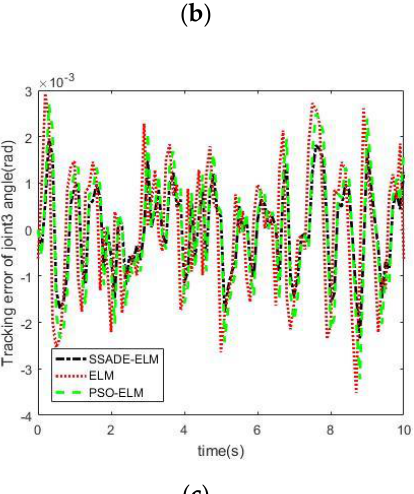
Figure 11. The tracking error of each joint trajectory of control algorithms by experiment. ( a ) The tracking error of Joint1 trajectory of control algorithms; ( b ) The tracking error of Joint2 trajectory of control algorithms; ( c ) The tracking error of Joint3 trajectory of control algorithms. Table 4. The average error of joint tracking of control algorithms by experiment. (SSADE–ELM = Strategy Self-Adaptation Differential Evolution–Extreme Learning Machine, PSO–ELM = Particle Swarm Optimization–ELM).